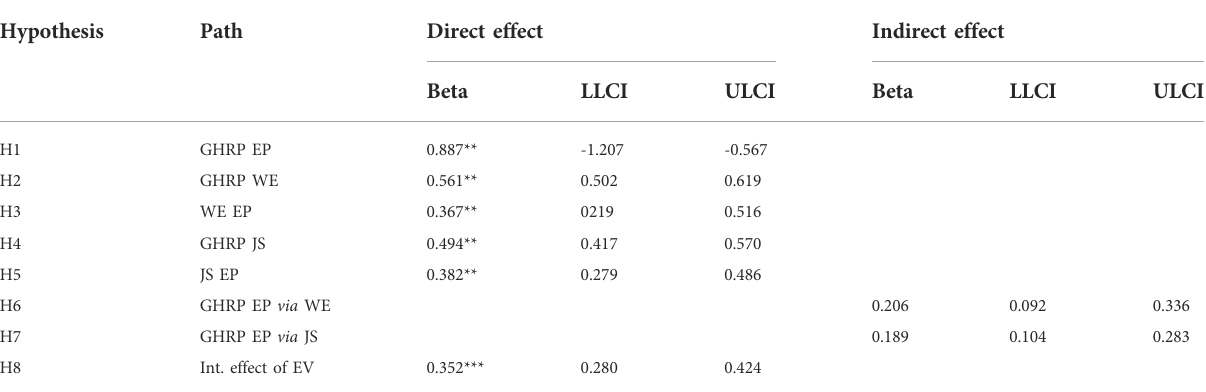
TABLE 2 Process macros